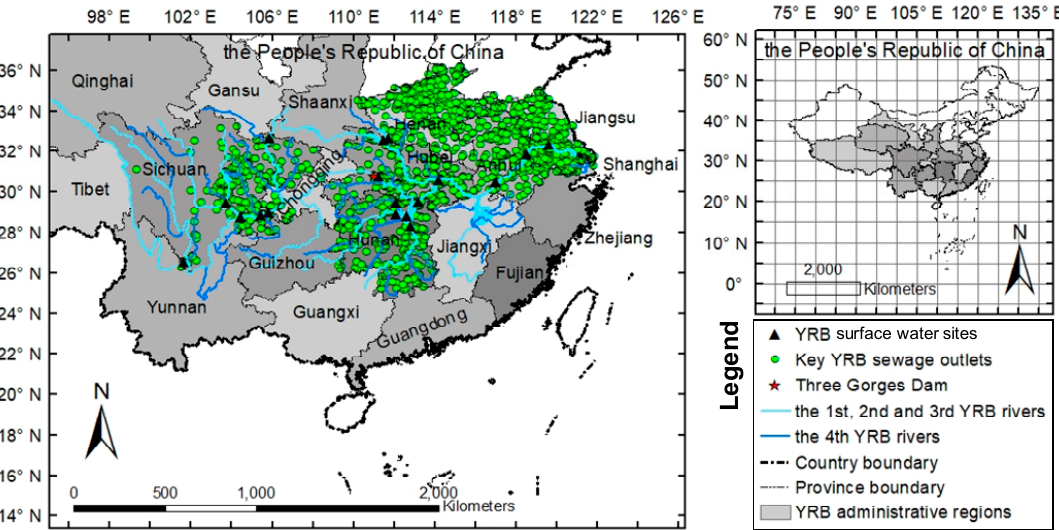
Figure 1. The 18 surface water sites that were part of the national monitoring program and the 2386 sewage outlets from the 2213 factories that were part of the national monitoring network in the 7 administrative regions (ARs) in the Yangtze River Basin YRB (YRB) in 2016 and 2017.